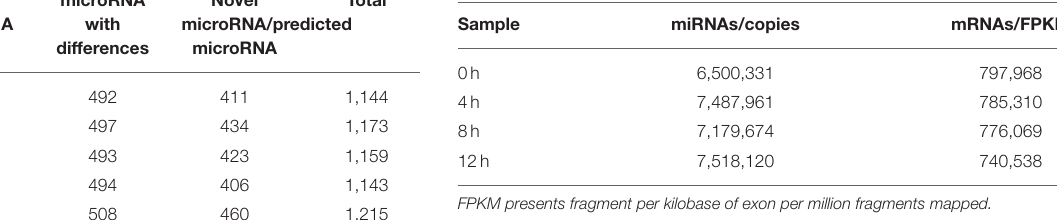
TABLE 4 | The total expression level of miRNAs and mRNAs at 0, 4, 8, and 12h, respectively.